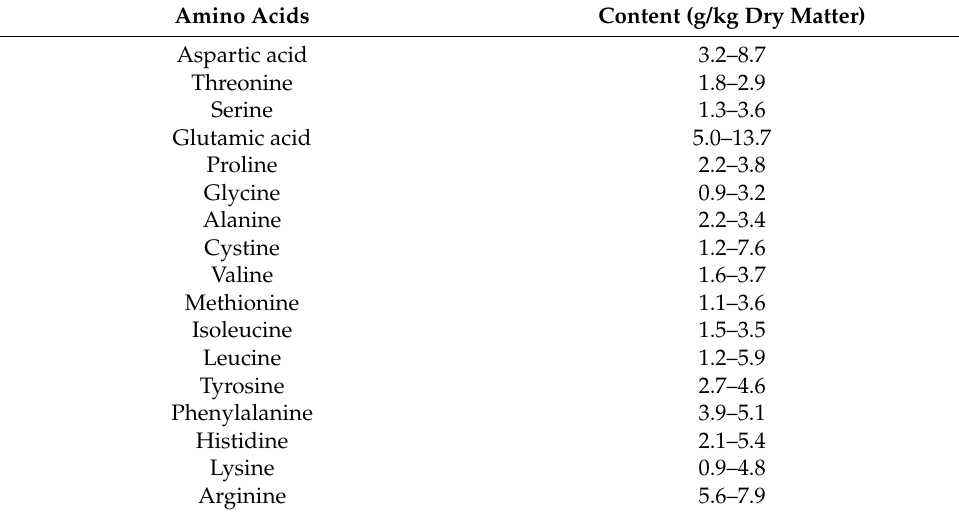
Table 3. Amino acid profile of soybean molasses